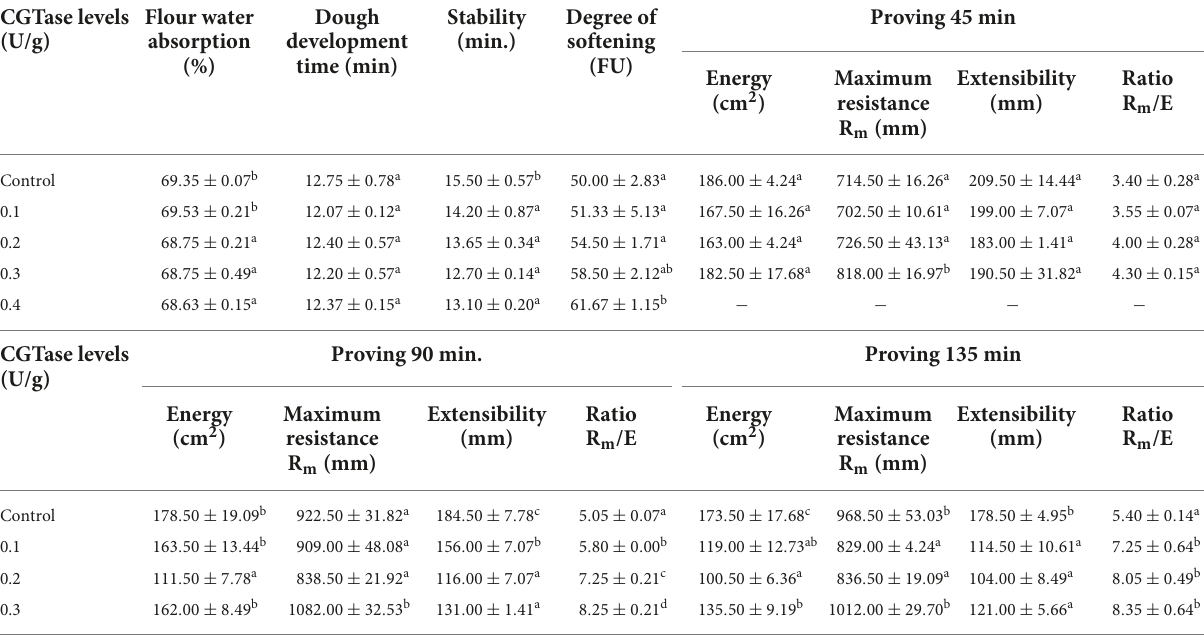
TABLE 1 Farinograph and extensograph analysis of doughs without or with CGTase.